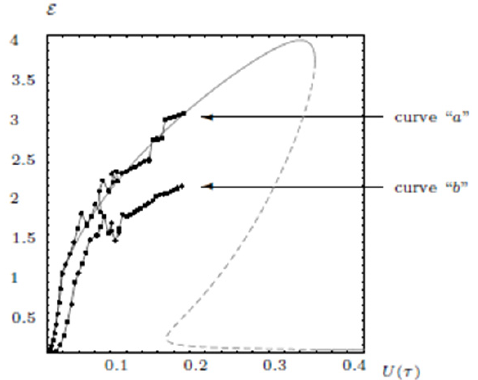
Figure 12: Elastic energy for increasing values of U. Curve: exact elastic energy.